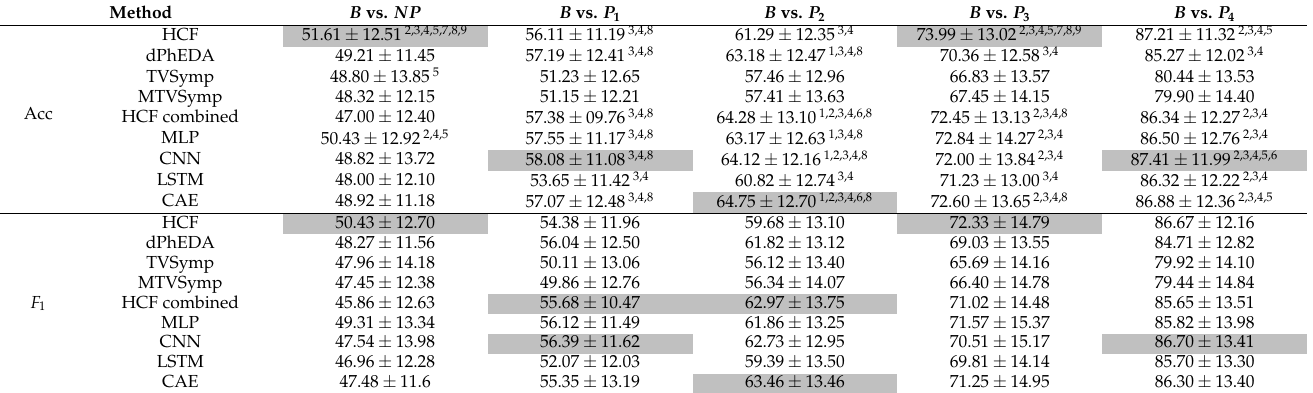
Table 9. 5 × LOSO average performance using the EDA (RespiBan) sensor of the PMDB for several feature extraction methods in combination with a Random Forest. Performance metrics are given as average accuracy (upper) and F 1 score (lower half) ± standard deviation. The best performing approach is highlighted in grey. Moreover, a paired student’s t -test with a significance level of 5% was performed to check the significance in differences between the accuracies obtained by each pair of approaches for each classification problem. 1,2,3,4,5,6,7,8,9 indicate a significant improvement compared to the HCF, dPhEDA, TVSymp, MTVSymp, “HCF combined”, MLP, CNN, LSTM, and CAE approaches,